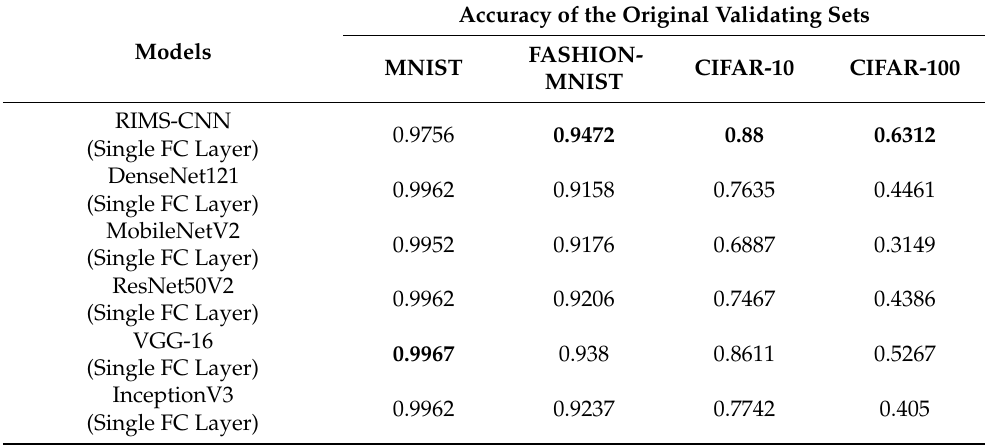
Figure 27. Evaluating different feature-extracting structures on the fixed-angle rotated CIFAR-100. Table 3. Evaluating models on the original training and validating